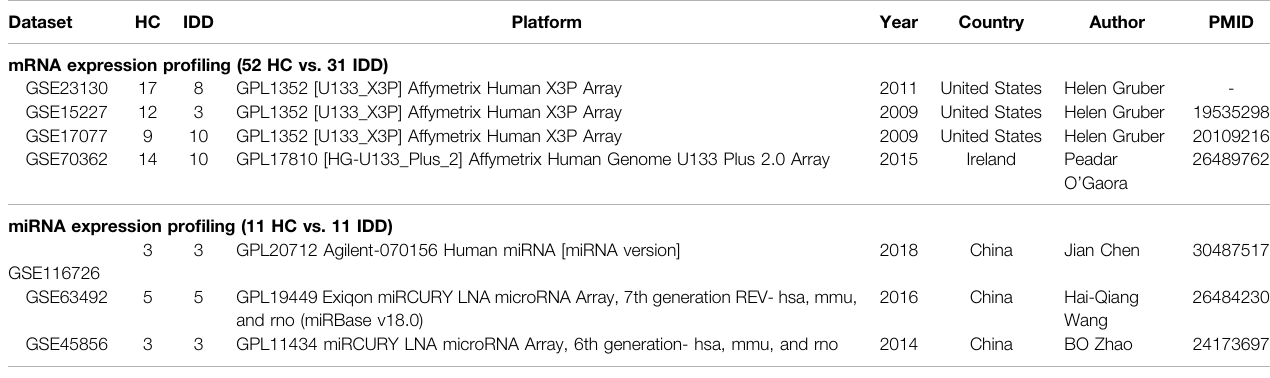
TABLE 1 | Detail information of microarray datasets.